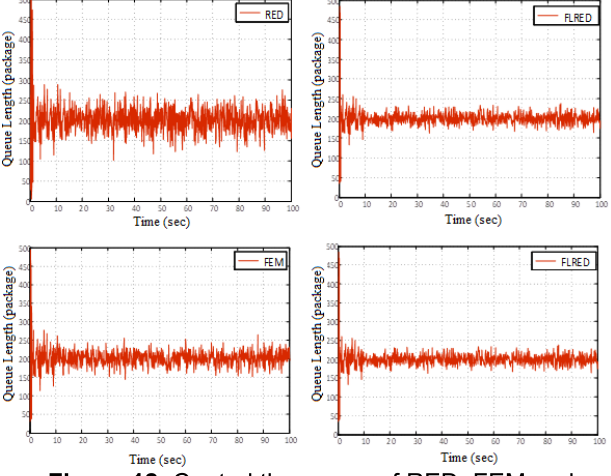
Figure 12. Control the queue of RED, FEM and